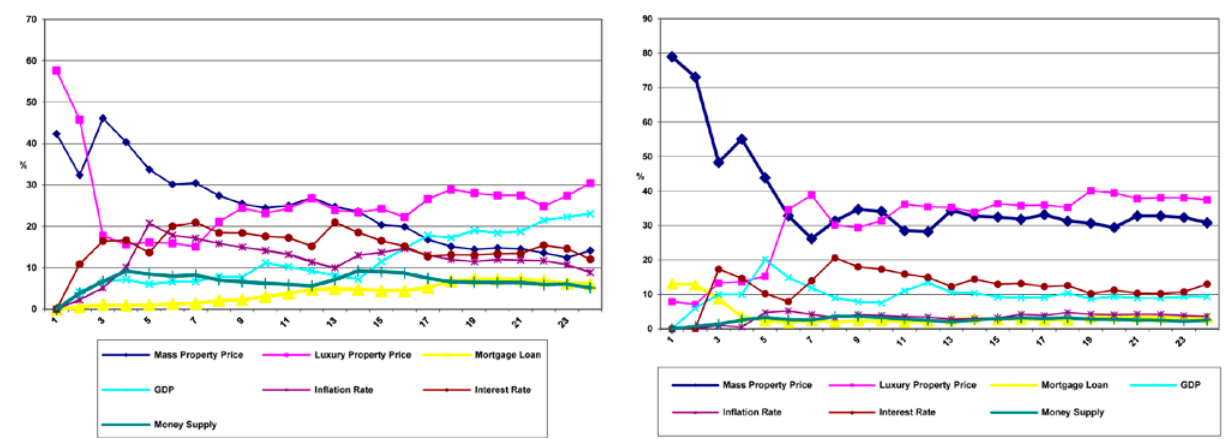
Fig. 8. Variance decomposition of luxury residential price